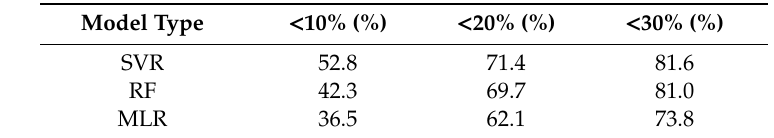
Table 3. The proportion of estimated data depends on the relative difference between actual dwell time and estimated dwell time by the model types.